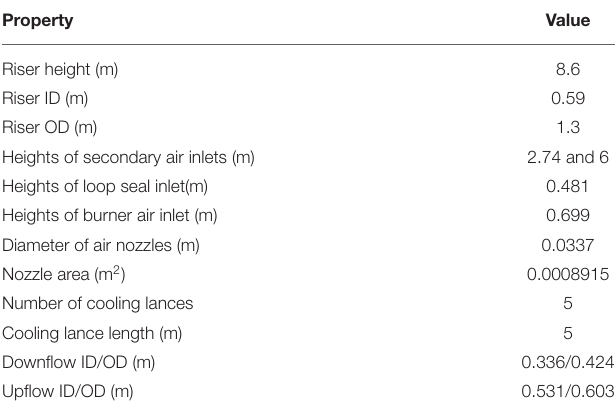
TABLE 1 | Design characteristics of the pilot CFB